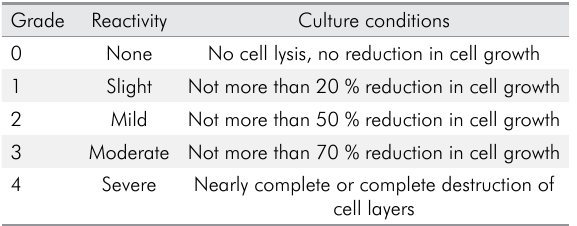
Table 2. Grade of cytotoxicity according with ISO 10993-5:2009 (E).